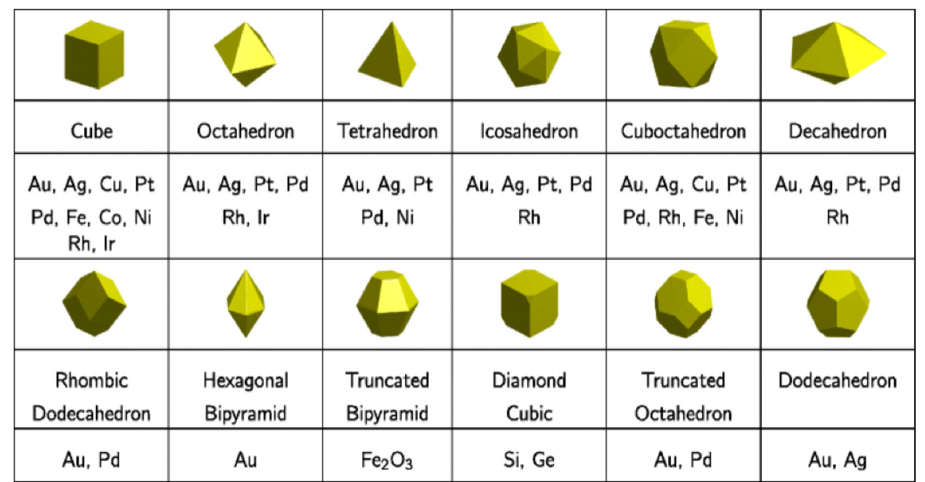
Figure 1. Shape ‐ dependent synthesized nanoclusters. Reprinted with permission from Reference [5]. Copyright 2020 Springer Nature.